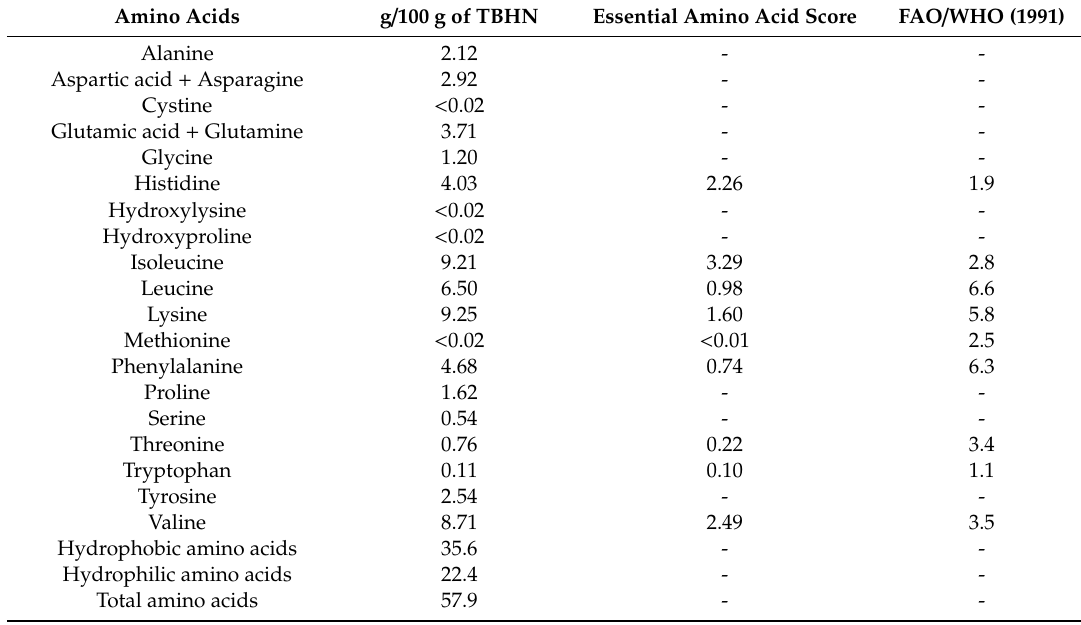
Table 4. Amino acid composition of TB hydrolysate using Neutrase hydrolysis (TBHN). Amino Acids g / 100 g of TBHN Essential Amino Acid Score FAO / WHO